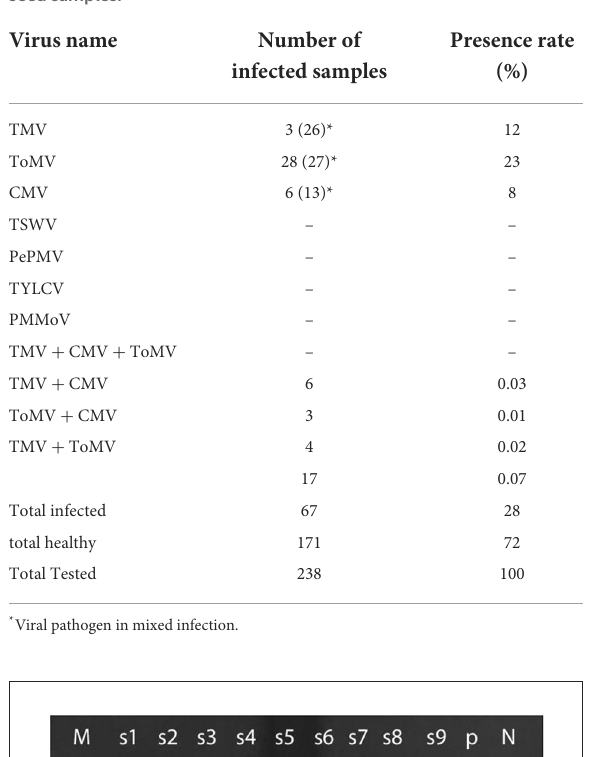
TABLE 3 Viruses detected as a result of serological tests in tomato seed samples.